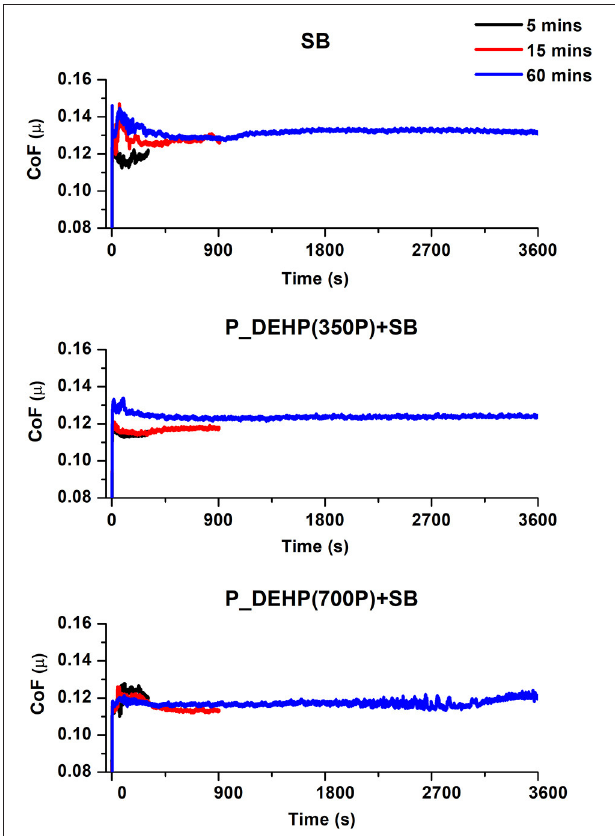
FIGURE 1 | Coefficient of friction obtained for oil blends containing only SB, P_DEHP(350P) + SB and P_DEHP(700P) + SB. Showing the friction response of each oil blend for 5, 15, and 60min